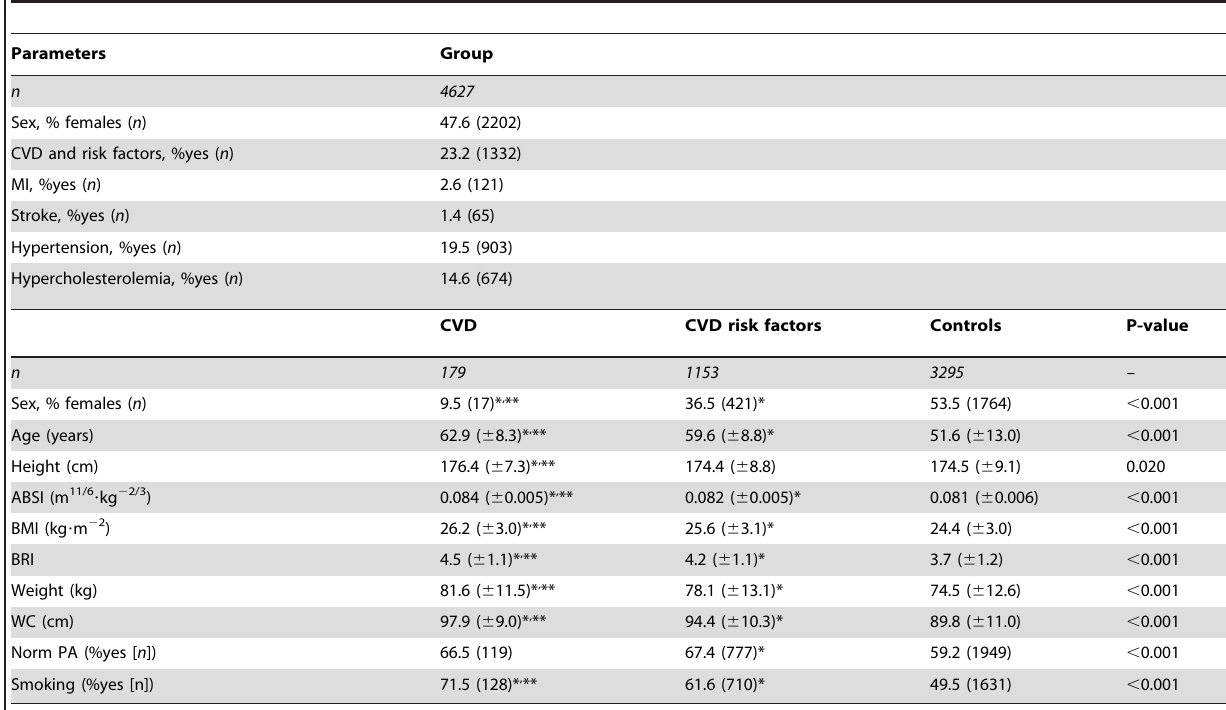
Table 1. Characteristics of the total study population and according to cardiovascular disease status.